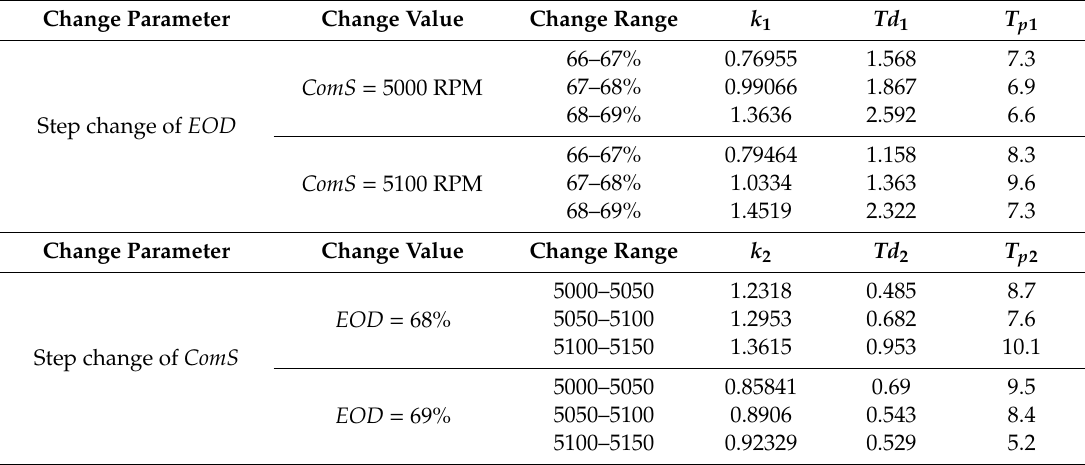
Table 2. Partial values of k , Td and T